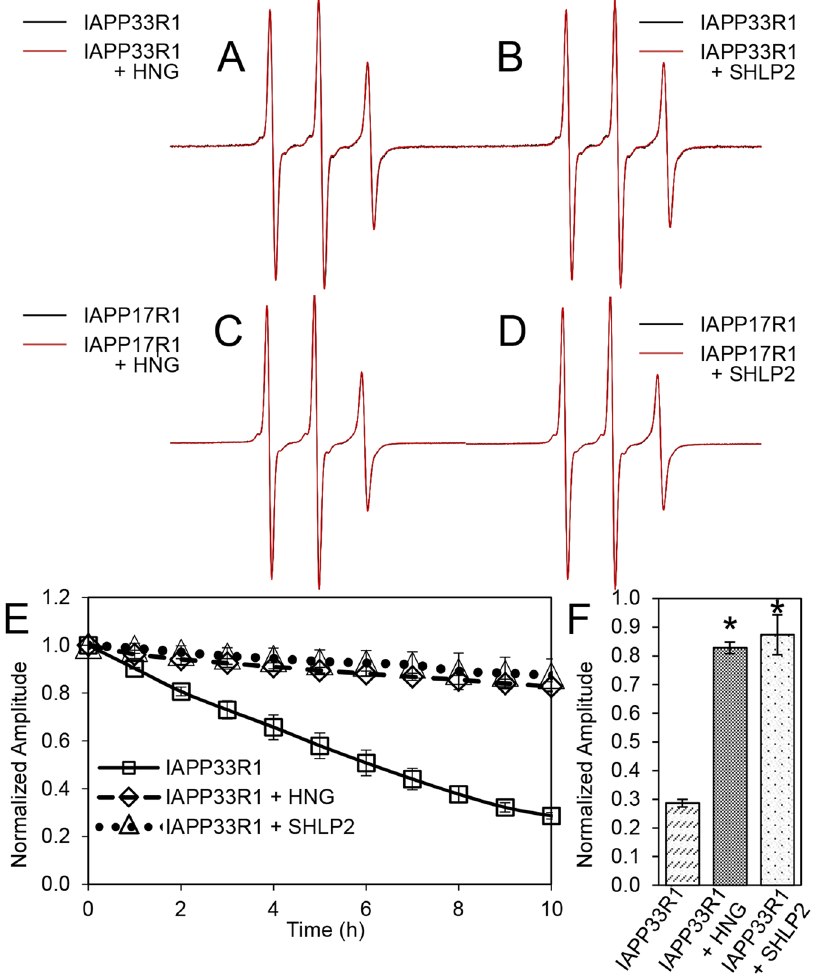
(black) and with SHLP2 (red), (c) IAPP17R1 alone (black) and with HNG (red), (d) IAPP17R1 alone (black) and with SHLP2 (red). ( E ) IAPP misfolding kinetics monitored over the course of fibrilization by central line amplitude. Symbols represent the following: ( □ ) IAPP33R1, ( ◊ ) IAPP33R1 + HNG, ( ∆ ) IAPP33R1 + SHLP2. Error bars represent + / − 1 standard deviation. p-values of MDP treated vs. untreated IAPP33R1 at 1 hr < 0.05, and at 2 + hr < 0.01. ( F ) Average central line amplitudes for MDP treated IAPP33R1 at hour 10, * p = 0.001. Error bars represent + / − 1 standard deviation from a minimum of 3